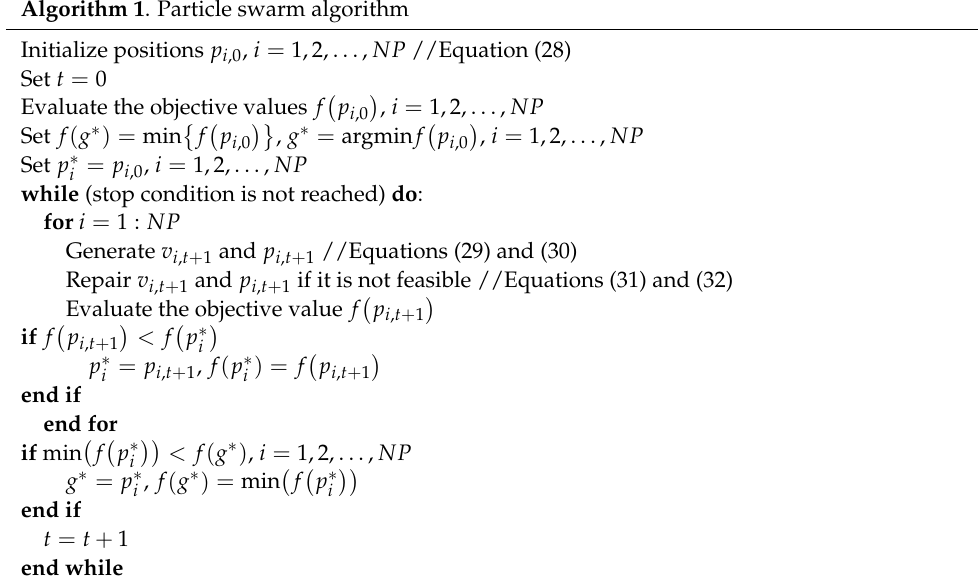
Algorithm 1 . Particle swarm